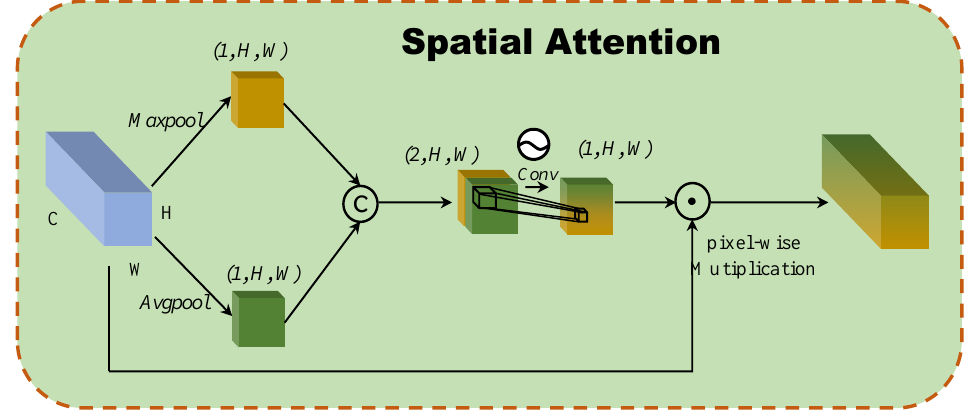
Figure 3. The architecture of 2D spatial attention block.